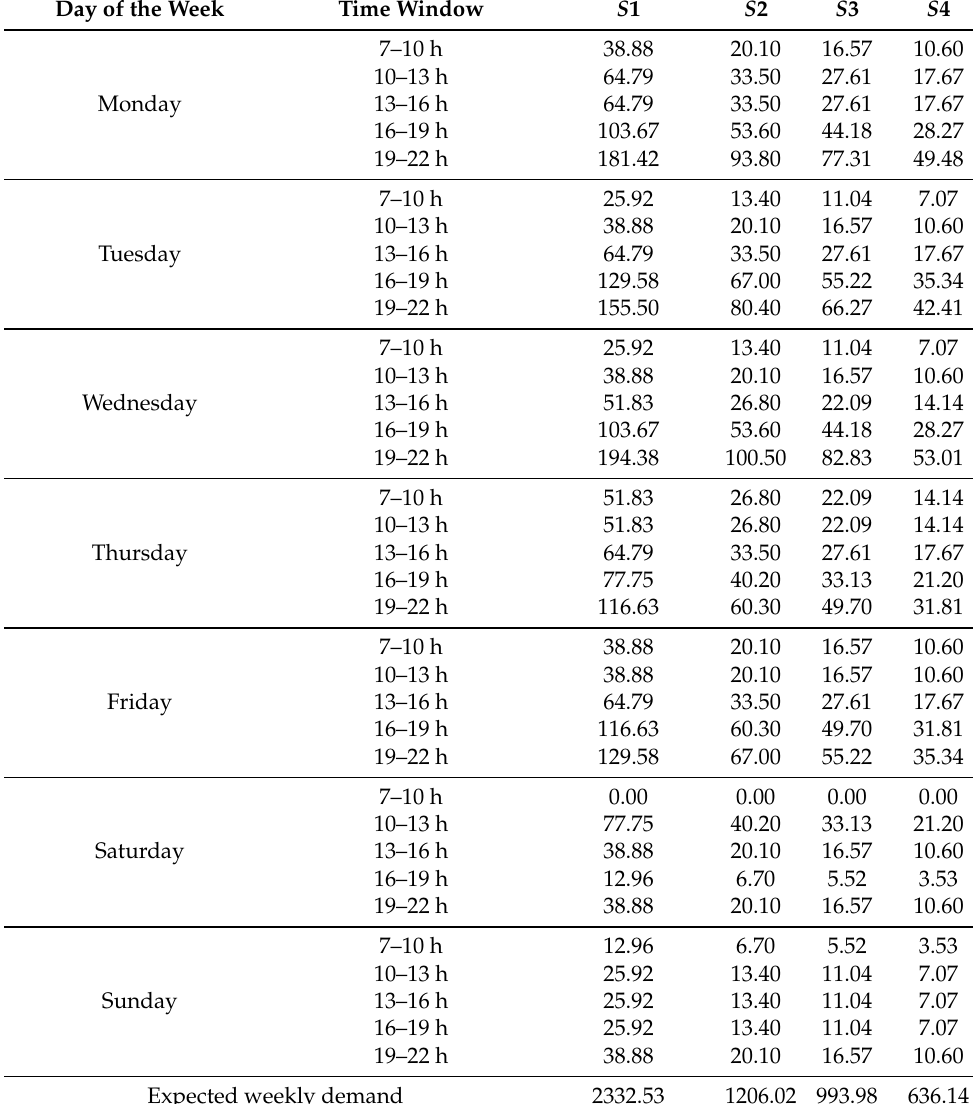
Table 2. Expected demand (number of orders) per time window and day of the